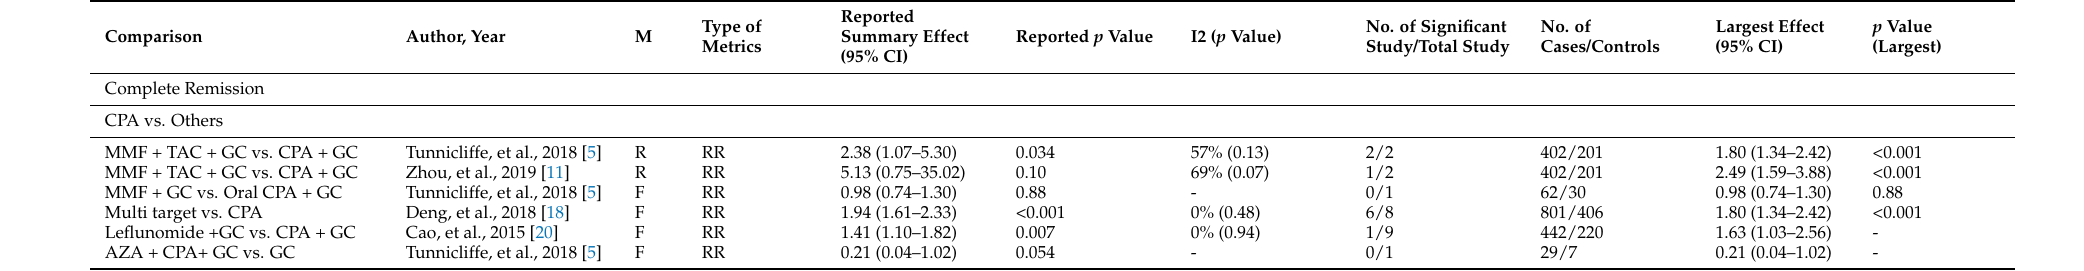
Table 2. Complete and partial remission rates of induction therapy in lupus